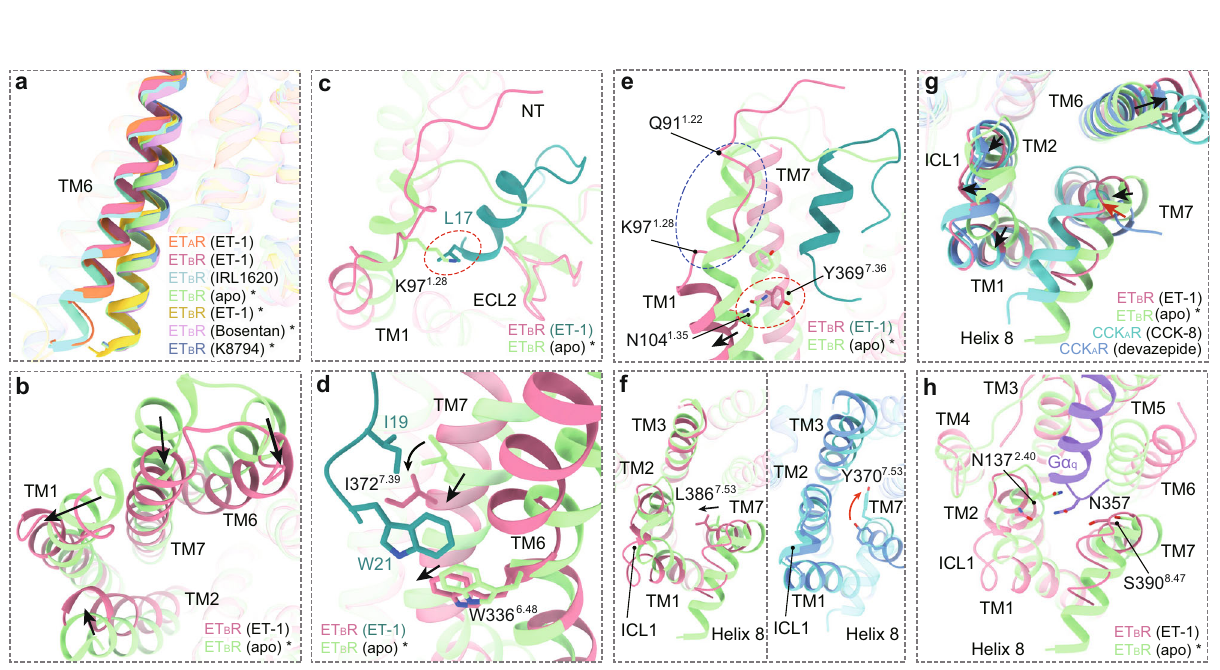
ET-1-ET A R complex structure is omitted for a clear presentation. The electrostatic potential was calculated and presented using PyMOL. Deep blue represents posi- tively charged and red represents negatively charged areas.